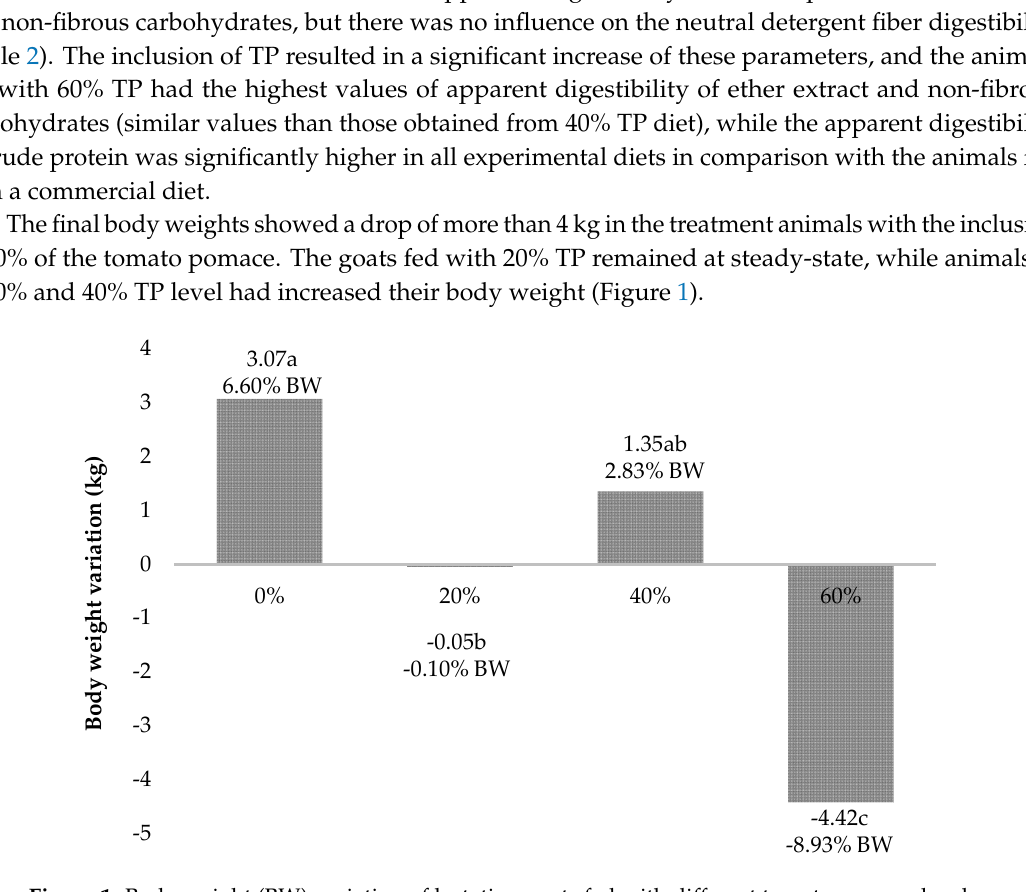
Figure 1. Body weight (BW) variation of lactating goats fed with different tomato pomace levels.